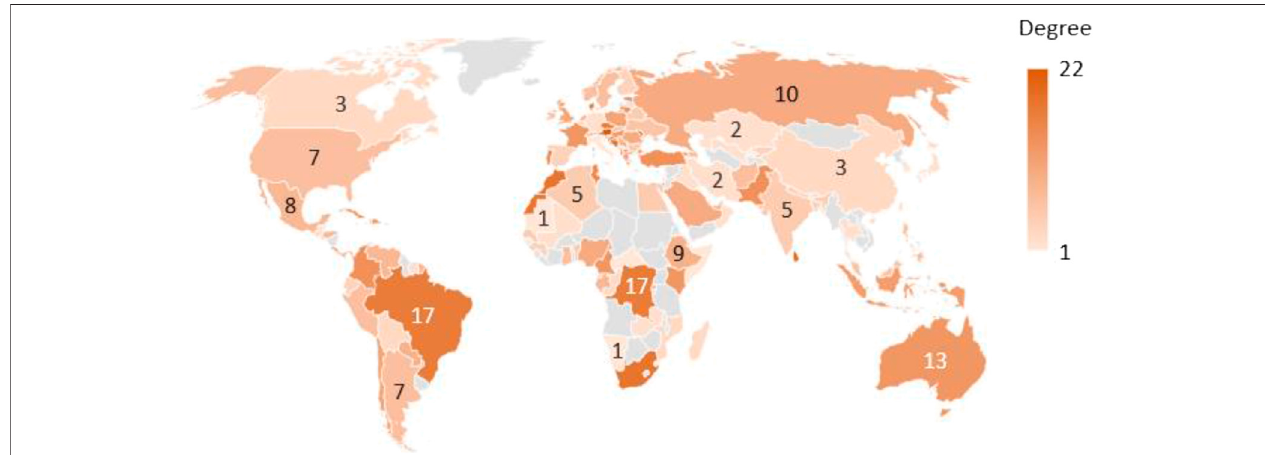
FIGURE 4 | The degree of the global COVID-19 pandemic network.